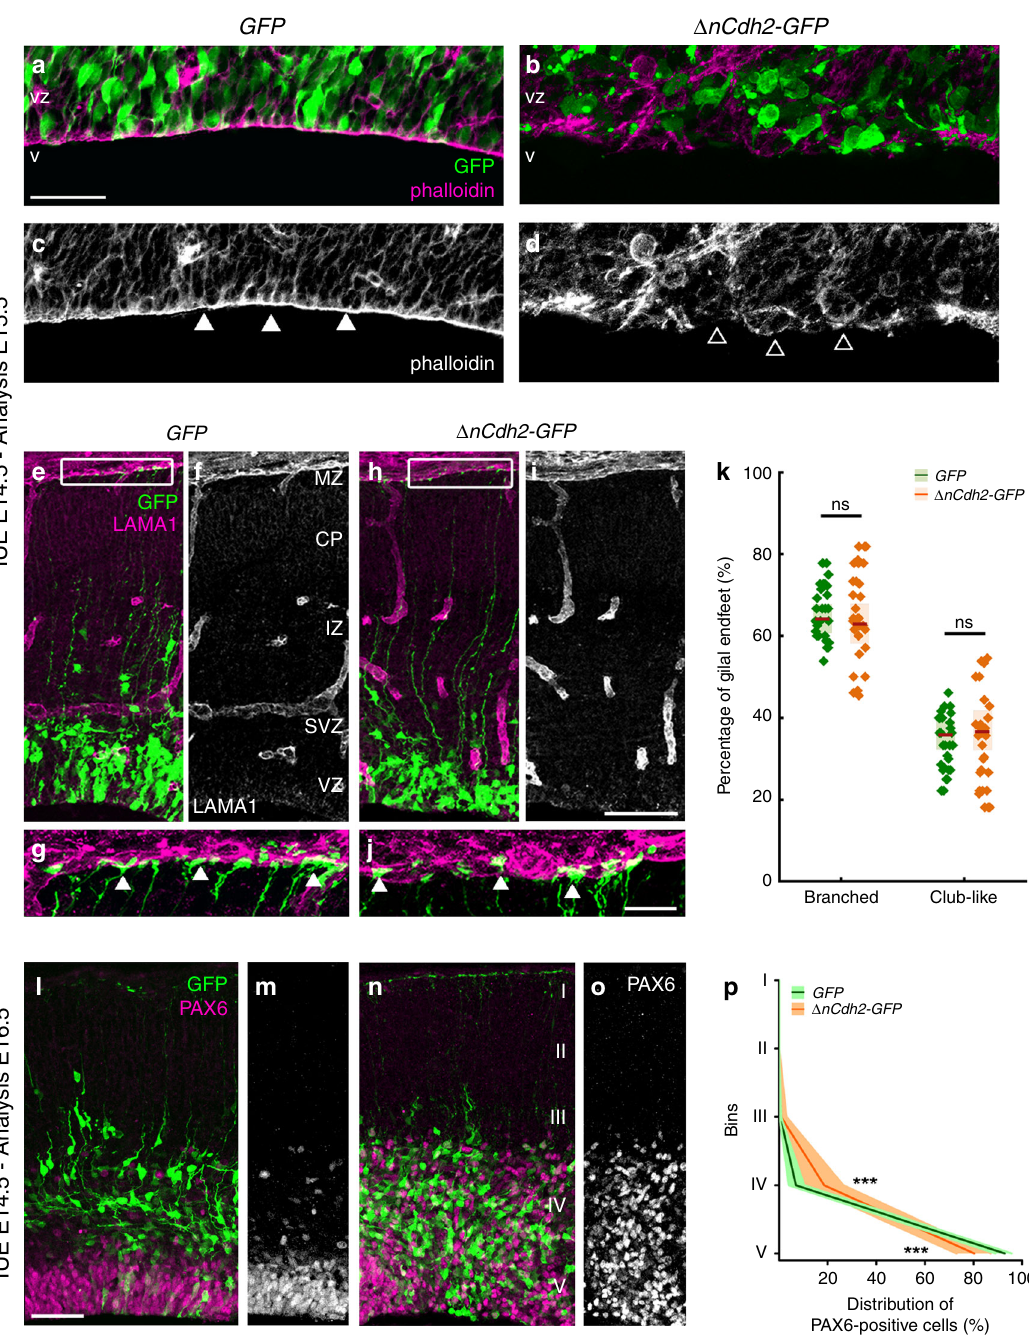
Fig. 1 Adherens junction disruption induces ectopic accumulation of PAX6-positive cells. High-power fl uorescent micrographs of the ventricular zone (VZ) show the adherens junction belt (white arrowheads) around the ventricle (V). Δ nCdh2-GFP- ( b , d) , but not control GFP- in utero electroporation (IUE) ( a , c ), demolishes adherens junctions (open arrowheads). e – j Laminin (LAMA1)-immunostaining of the developing cerebral cortex from GFP - and Δ nCdh2- GFP -electroporated embryos. High-power images ( g , j ) demonstrate that the attachment of the basal endfeet of RGPCs to the pial surface is not affected directly by the disruption of cadherin-based adherens junctions at the ventricular surface. k Selective damage of the apical adherens junction does not affect the two main morphological types of radial glia endfeet at the basal surface (two-sided Student ’ s unpaired t test, P = 0.951; n = 43 sections from n = 3 animals per GFP treatment, n = 37 sections from n = 3 animals per Δ nCdh2-GFP -treatment). Graphs show box-and-whisker plots (including minima, maxima and median values, lower and upper quartiles) with single values. l – o Breakdown of adherens junctions prompts delamination ( g – h ) and ectopic accumulation of PAX6-positive cells in the subventricular zone. p Distribution of PAX6-positive cells in fi ve equal bins (Roman numerals) (two-sided Mann – Whitney U test for all comparisons; 4th bin *** P = 0.0004 and 5th bin *** P = 0.0003; n = 13 sections from n = 3 animals per GFP treatment; n